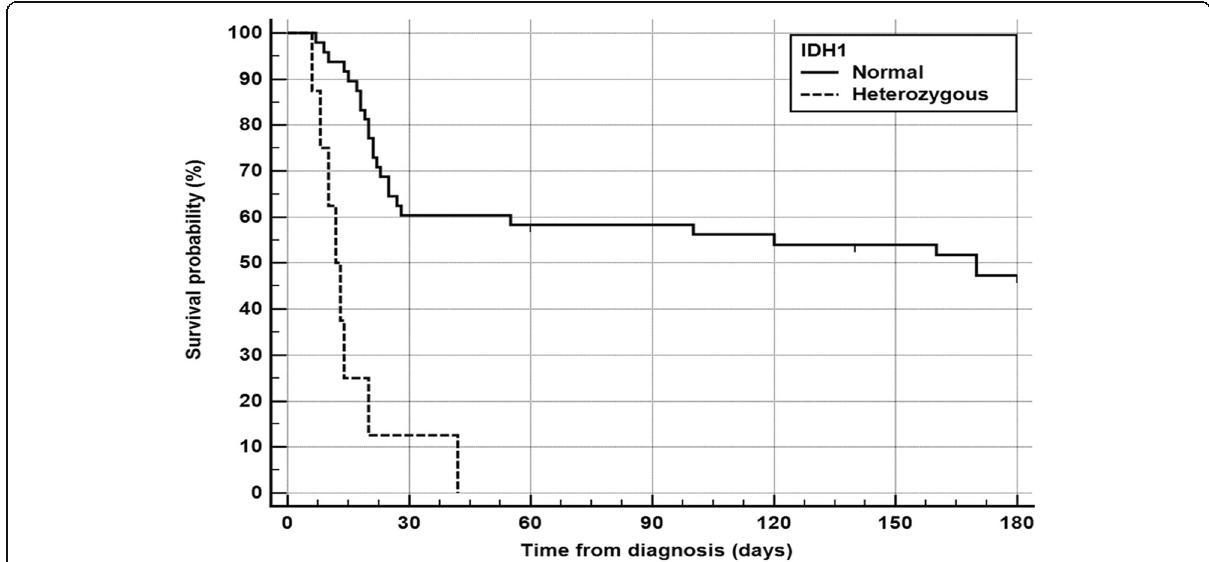
Fig. 2 Kaplan-Meier survival curves in patients with normal or heterozygous IDH1. There is a statistically significant difference between both